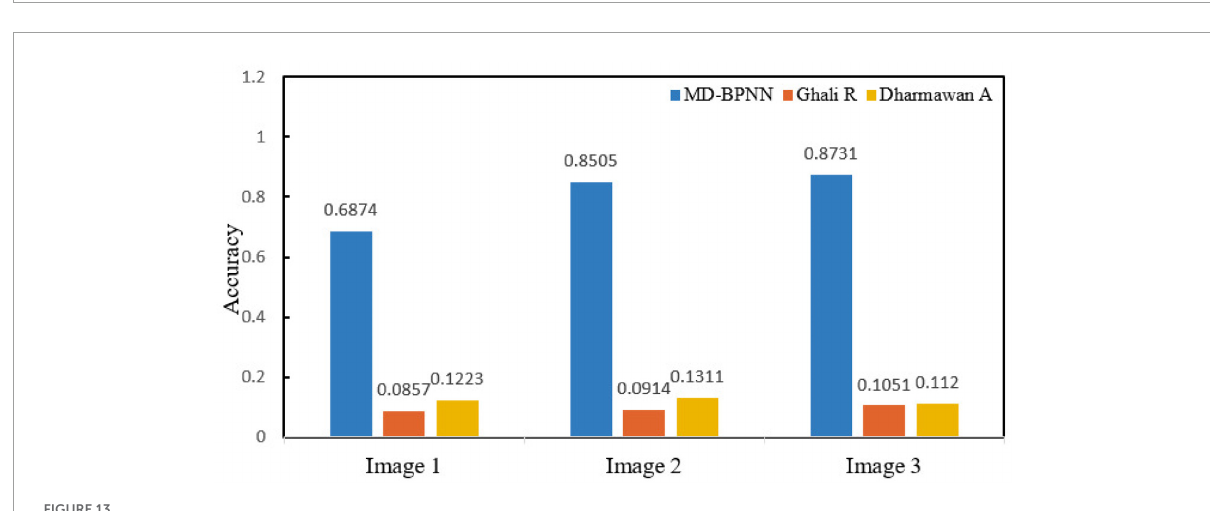
FIGURE13 HAF evaluation index